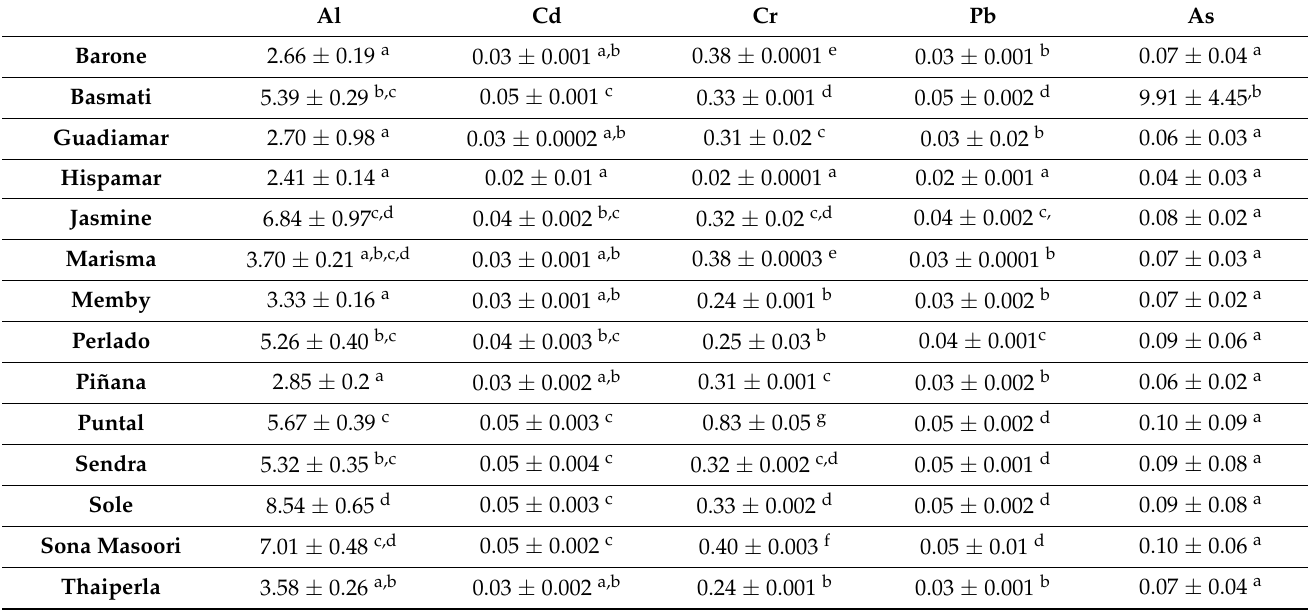
Table 11. Percentage of assimilated metallic elements respect to toxic threshold